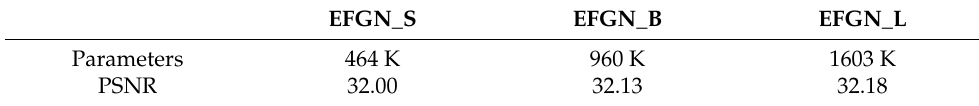
Table 2. Results of different parameter setting in SIRU on Set5 dataset with scaling factor 4.